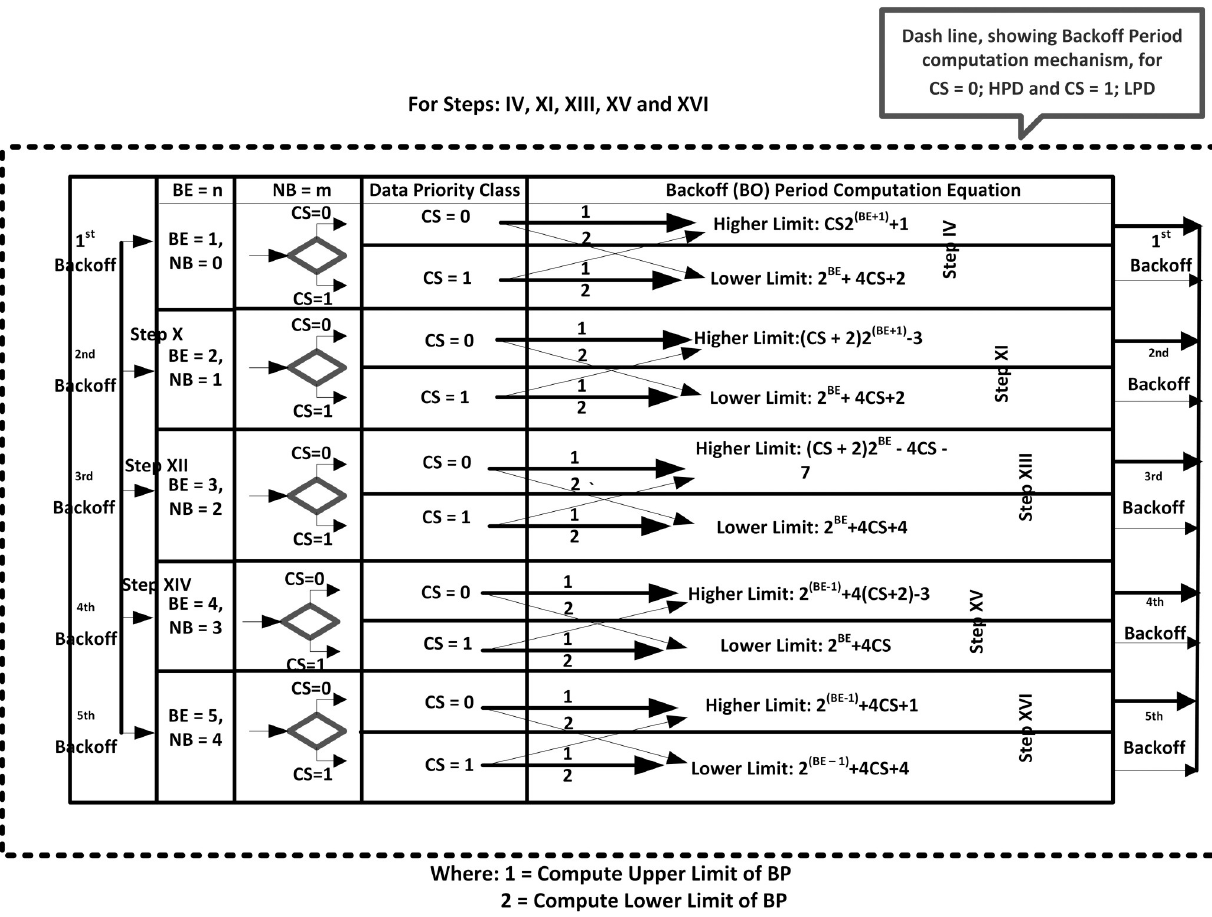
Fig 7 shows the flowchart diagram of how the CSTP-MAC scheme operates for a node intending to engage in a transaction. The operational workflow is explained in the steps below: